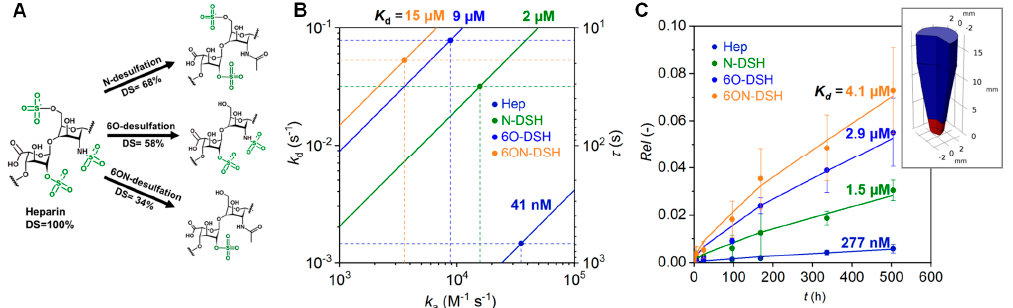
Figure 4. ( A ) Schematic representation of the selective removal of heparin’s sulfate groups at one or more positions resulting in different degrees of sulfation (DS). ( B ) Plot of dissociation rate constants, k d , vs the association rate constants, k a , for K d values ( K D = k d / k a ) obtained from biolayer interferometry (BLI) for the interaction of PDGF-BB with the heparin derivatives. In combination with the dashed lines, the circles indicate the rate constants k d and k a determined via BLI. The solid lines represent all possible combinations of k a and k d associated with the given K d values. The parameter τ is the residence time, characterizing the life time of the PDGF-BB-heparin complexes. ( C ) Release of PDGF-BB from hydrogels formed from starPEG and heparin derivatives. Circles represent experimental data and the solid lines release profiles calculated on the basis of a reaction-diffusion model. The release experiments were performed in low protein binding tubes, see inset. The volume shown in red represents the hydrogels and the volume shown in blue the release medium. Adapted from [12] with permission, Copyright Elsevier, 2018.